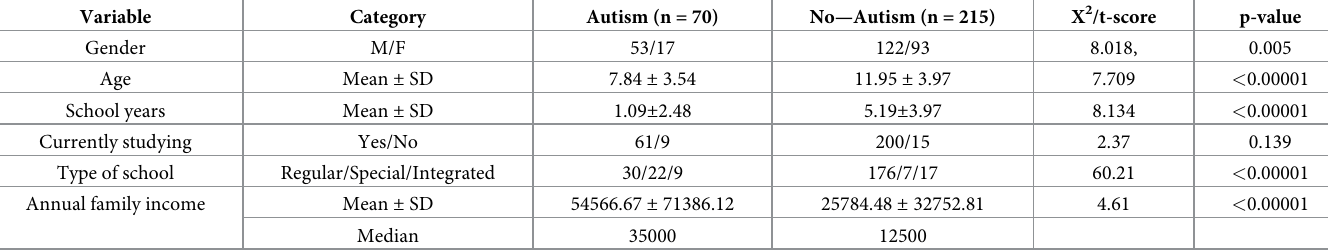
Table 1. Sociodemographic profile of the sample (n =